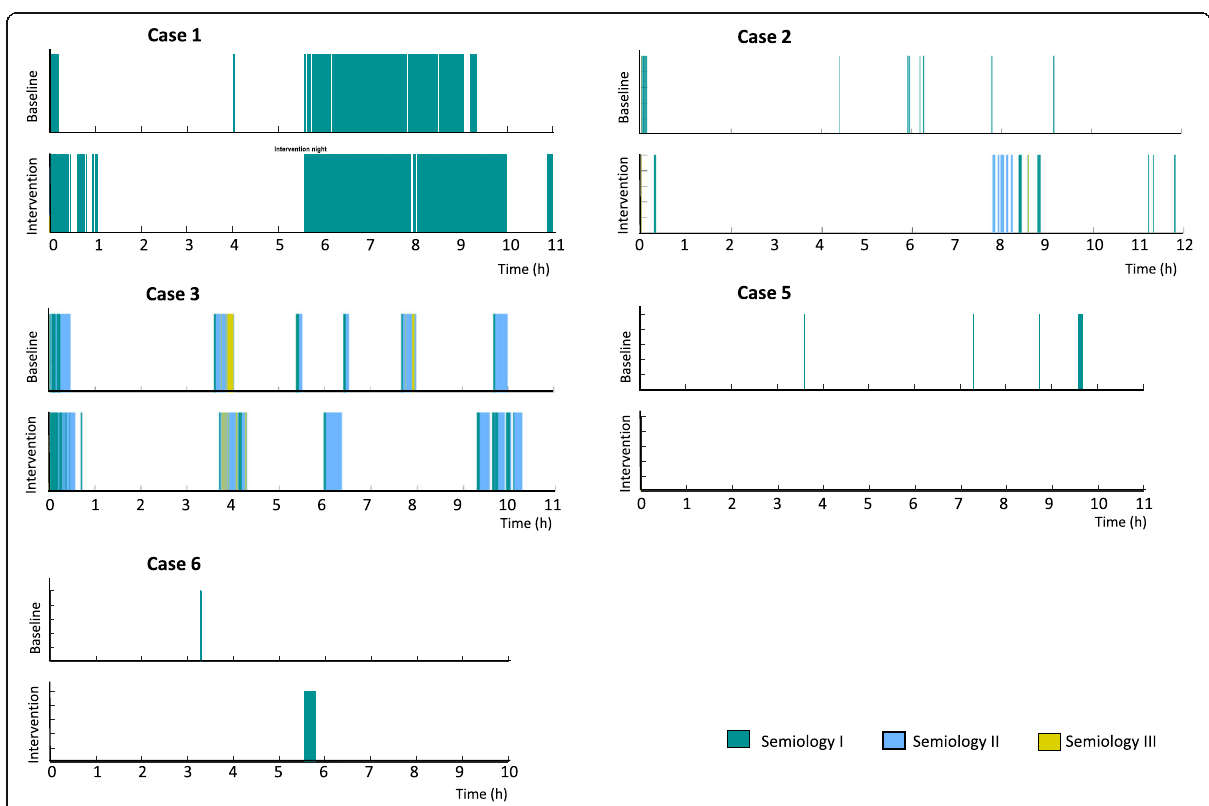
Fig. 4 Episodes of rhythmic movement during the baseline and intervention night for each case that showed rhythmic movement in the laboratory. Observed semiologies for case 2 were head banging (I: while bed was moving in habitual direction, II: bed moving perpendicular to habitual movement) and body rocking. Observed semiologies for case 3 were I: body rocking sideways and II: body rocking forward, furthermore lying still on all fours was observed (III). Case 4 did not show any movements in the two